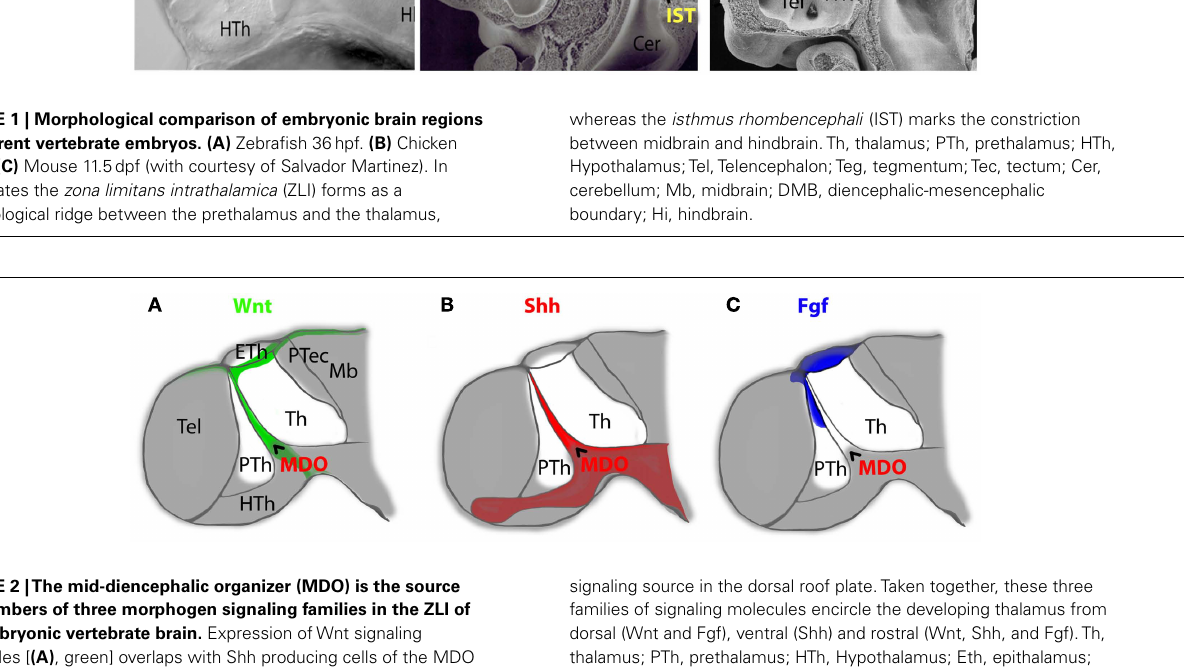
FIGURE 2 |The mid-diencephalic organizer (MDO) is the source for members of three morphogen signaling families in the ZLI of the embryonic vertebrate brain. Expression ofWnt signaling molecules [ (A) , green] overlaps with Shh producing cells of the MDO [ (B) , red], whereas expression of members of the Fgf family [ (C) , blue] is located in the prethalamus and overlaps partially with theWnt